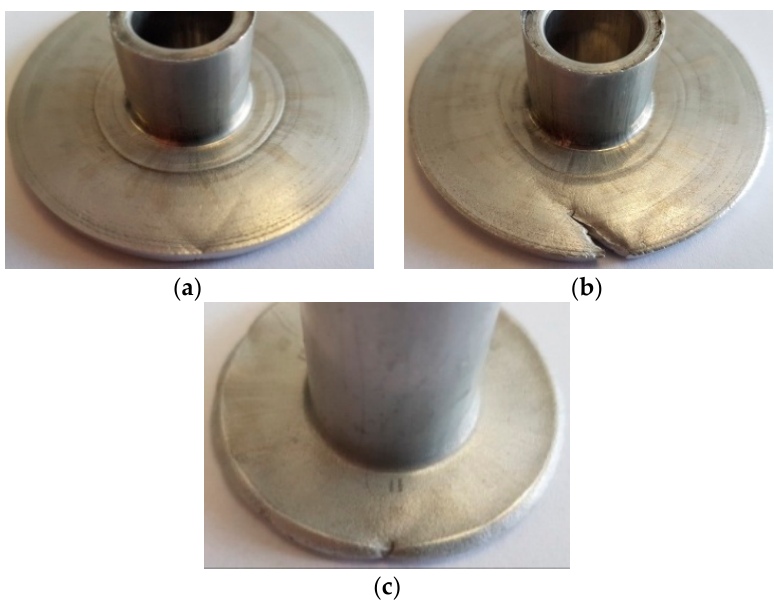
Figure 6. Hollow part with a flange produced by ( a ) incremental radial extrusion—crack formation, ( b ) incremental radial extrusion—visible crack, ( c ) radial extrusion without rings—visible crack.